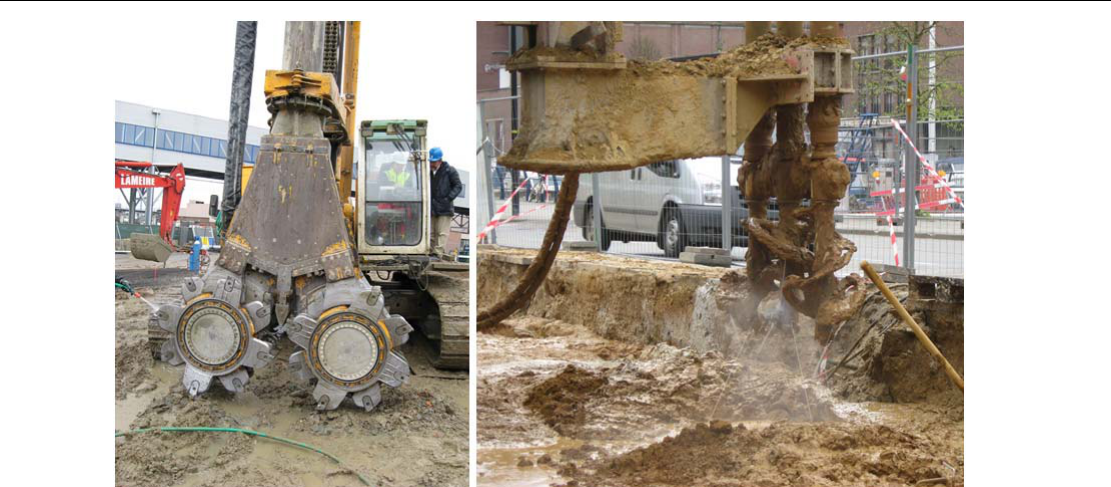
Figure 1. Illustration of typical deep mixing equipment in action on Belgian construction sites: Cutter Soil Mix (CSM) system of Bauer (left) and triple shaft configuration TSM system of Smet F&C (right).